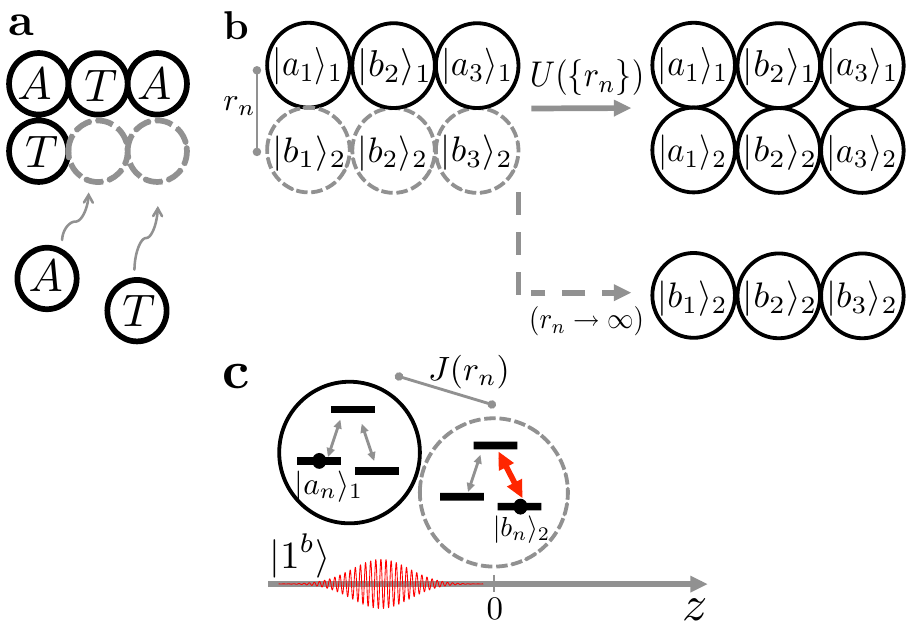
Figure 1. Natural versus artificial gene self-replication. ( a ) Simplified picture of a self-replicating biological gene. A single nucleic acid strand forms the original gene with nucleotide bases A , T and A . The complementary environment bases, T , A and T , form the copy. In the process, the bare states (dashed gray circles) undergo a transformation to the filled states (full black circles) dictated by the original a 1 b 2 a 3 gene (curved arrows). ( b ) A sequence of states 1 1 1 (full black circles) specifies the original | � | � | � 1, 2, 3 b n quantum artificial gene. The environment bases are initially set to their ground states, 2 , for n = | � (dashed gray circles), which can be regarded as bare states. In the process, the bare states undergo a transformation to a filled state (full arrow), dictated by (and ideally identical to) the original gene state, a 1 b 2 a 3 b 1 b 2 b 3 a 1 b 2 a 3 a 1 b 2 a 3 1 1 1 2 2 2 1 1 1 2 2 2 . This transformation is described by | � | � | � ⊗ | � | � | � → | � | � | � ⊗ | � | � | � r n ) for the global organism-plus-environment dynamics, including that of the source a unitary operator U ( } { r n ) depends on the free parameter r n , representing the distance between of energy. The unitary operator U ( } { the n -th gene base and its corresponding environment base. If r n , the environment bases are expected → ∞ to be left unchanged (dashed arrow). ( c ) Inspired by the idea that sunlight has been crucial to the transition 1 b from inanimate to living matter, here each single-photon pulse (red wavepacket described by the state ) | � drives (activates) a single environment base (lambda system in dashed gray circle). The pulse propagates b n e n towards the positive z direction and couples states 2 and 2 (red thicker double arrow). This light-matter | � | � dynamics depends on the couplings J ( r n ) between each original base (lambda system in full black circle) and the corresponding environment